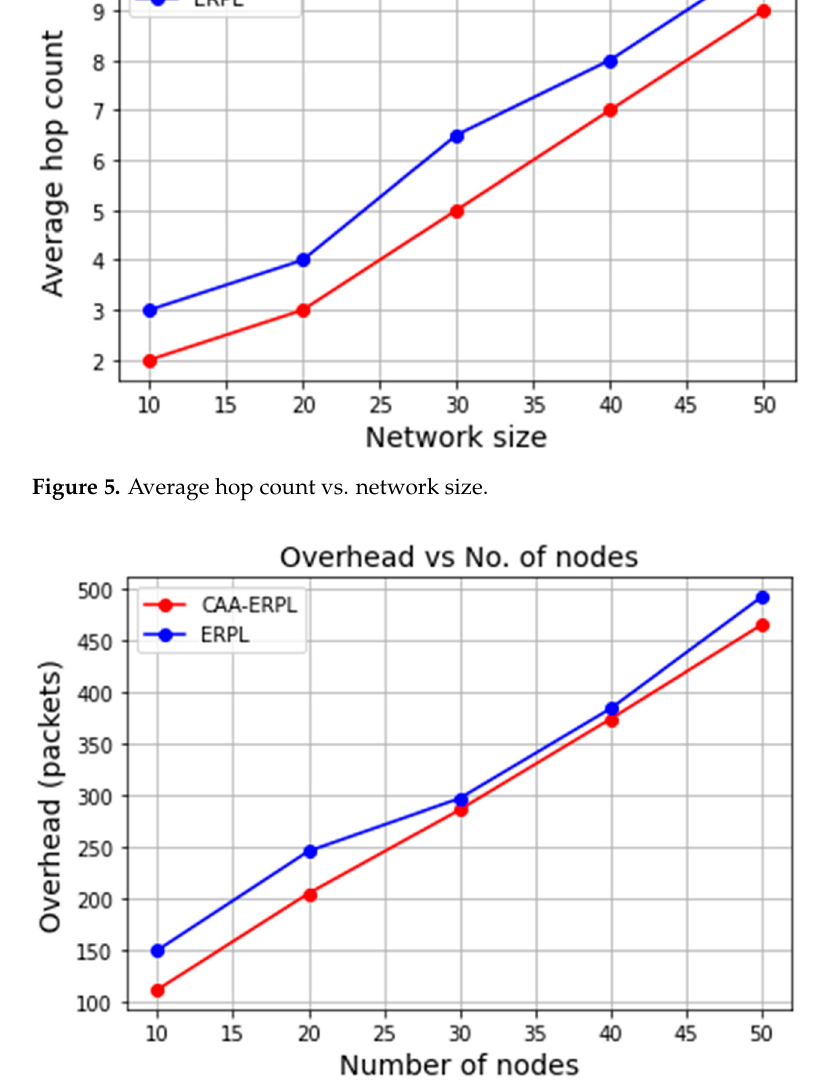
Figure 5. Average hop count vs. network size.